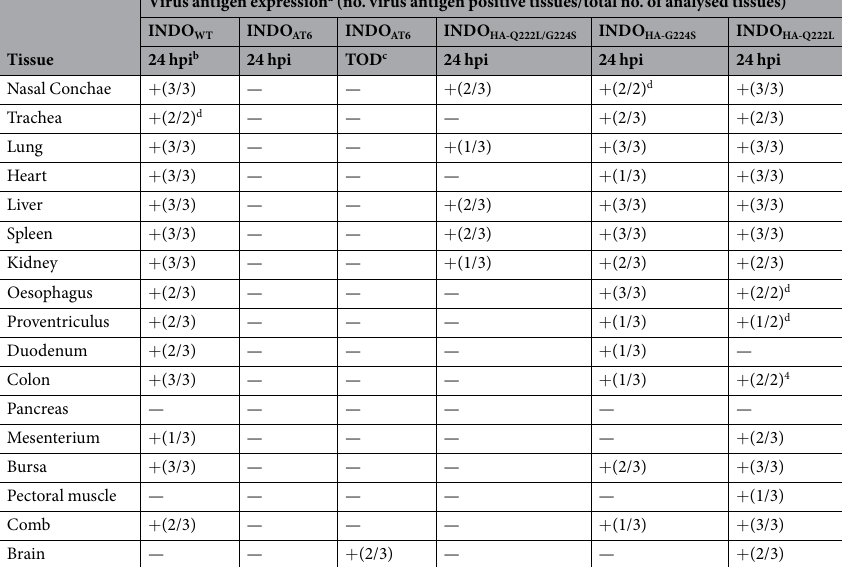
— — + (2/3) — — + (2/3) Table 2. Virus antigen expression in tissues of chickens upon inoculation with INDO WT , INDO AT6 , INDO inoculation. c TOD: Time of death. d Assay performed on tissues from only two